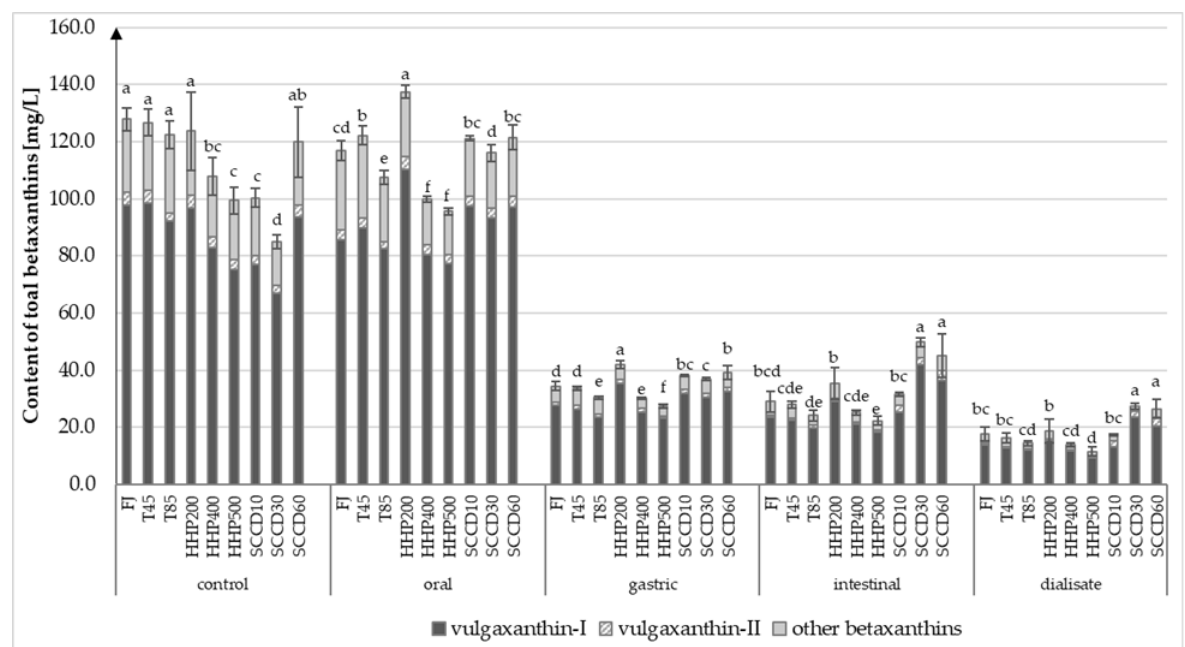
Figure 2. Content of total betaxanthins (vulgaxanthin-I, vulgaxanthin-II, and other betaxanthins) in beetroot juice after different processing on every stage of simulated gastro-intestinal digestion.